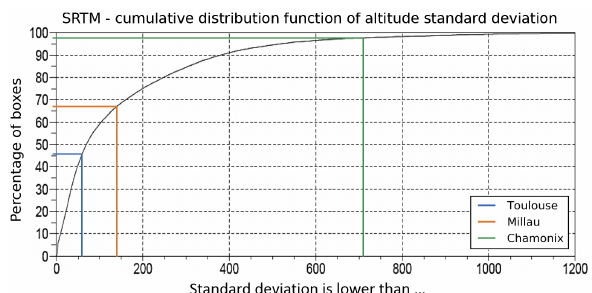
Figure 7. Global cumulative distribution of the standard deviation of altitude obtained on SRTM. A total of 46%, 67% and 97% of SRTM boxes present a lower standard deviation than the Toulouse scene, Millau scene and Chamonix scene, respectively. The three scenes are representative of medium, high and very high variations of